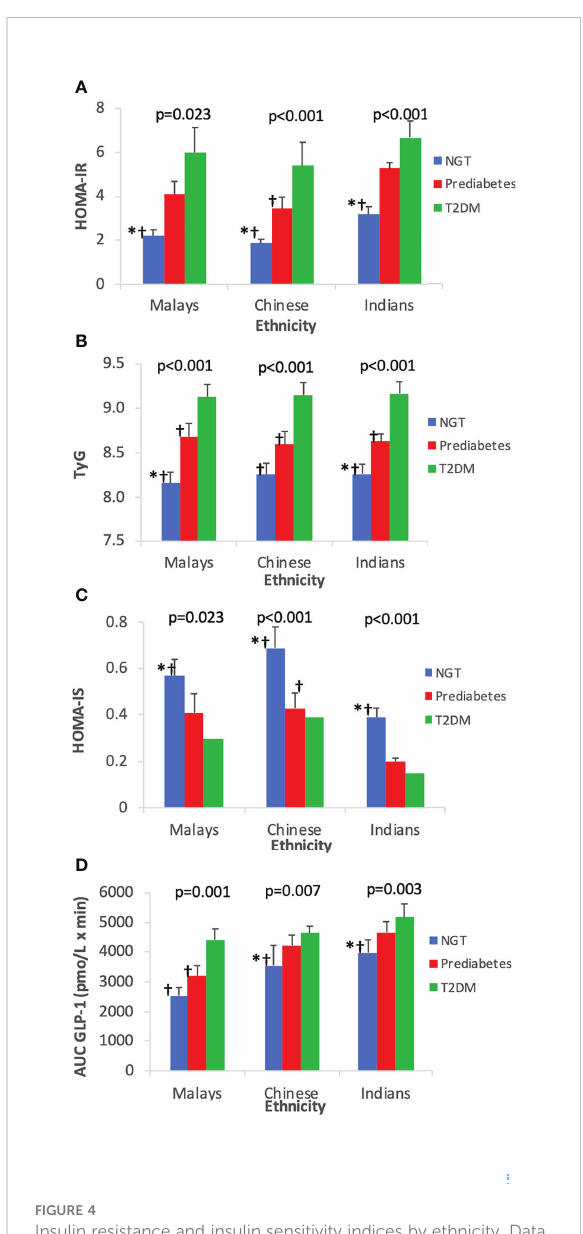
FIGURE 4 Insulin resistance and insulin sensitivity indices by ethnicity. Data are expressed as mean ± SD for (A) HOMA-IR, (B) TyG, (C) HOMA-IS, and (D) AUC GLP-1 . *p < 0.05 versus pre-diabetes, ƚ p < 0.05 versus T2DM. NGT, normal glucose tolerance; T2DM, type 2 diabetes mellitus; HOMA-IR, homeostasis model assessment of insulin resistance; HOMA-IS, homeostasis model assessment of insulin sensitivity; TyG, triglyceride – glucose